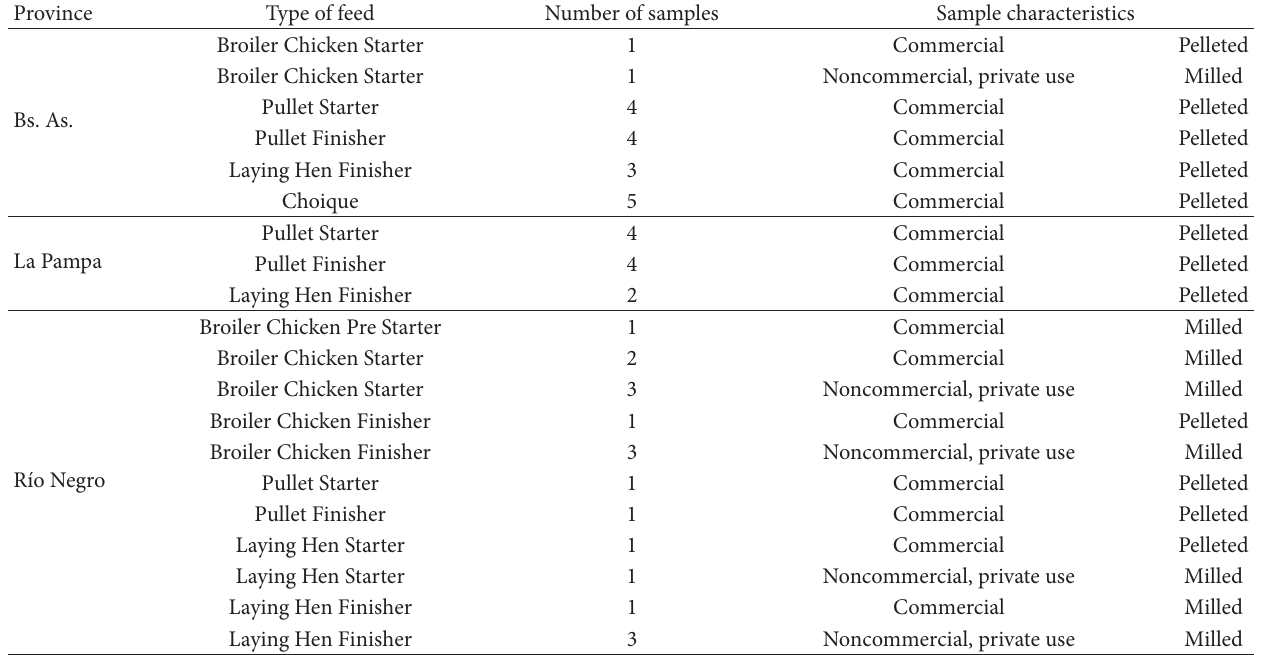
Table 1: Characteristics of the samples